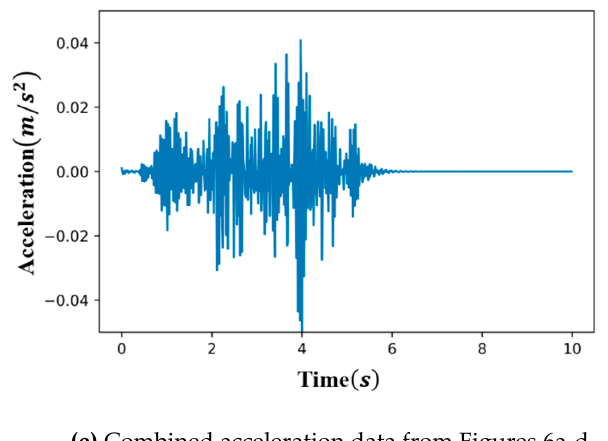
Figure 6. Example of the combination of base data.